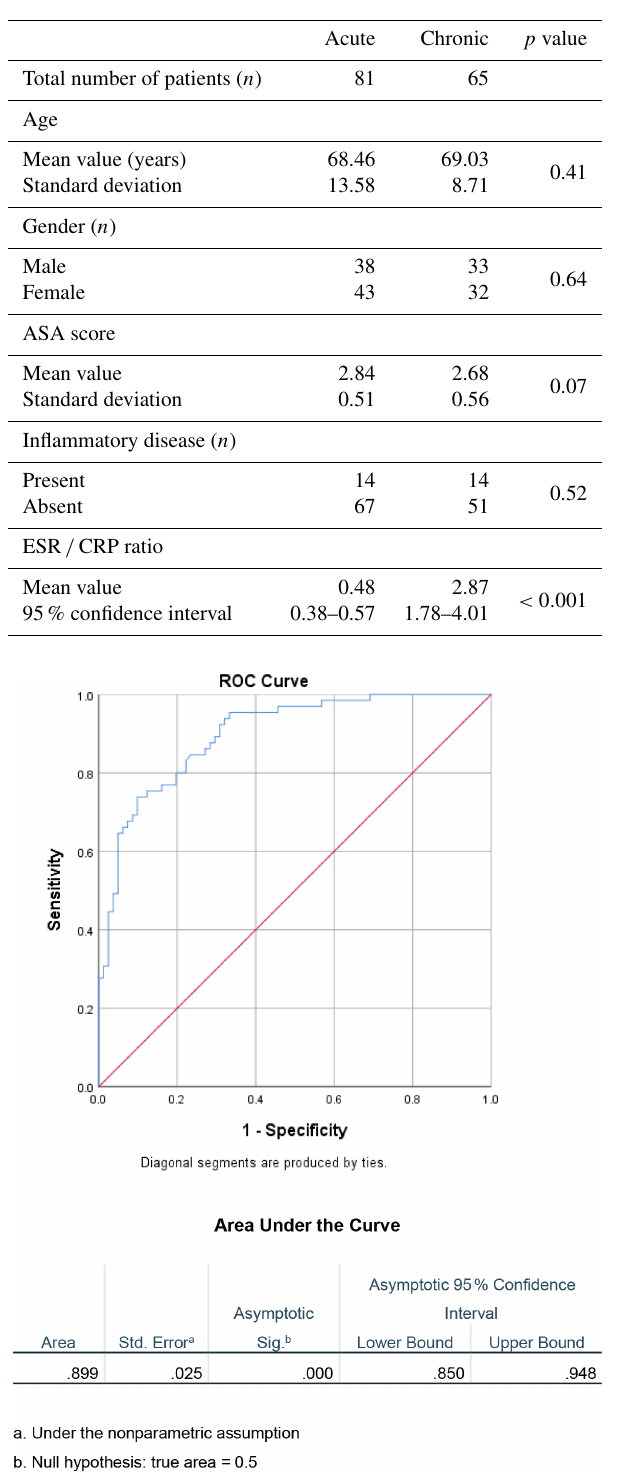
Figure 1. ROC curve and AUC for ESR / CRP ratio in acute vs. chronic